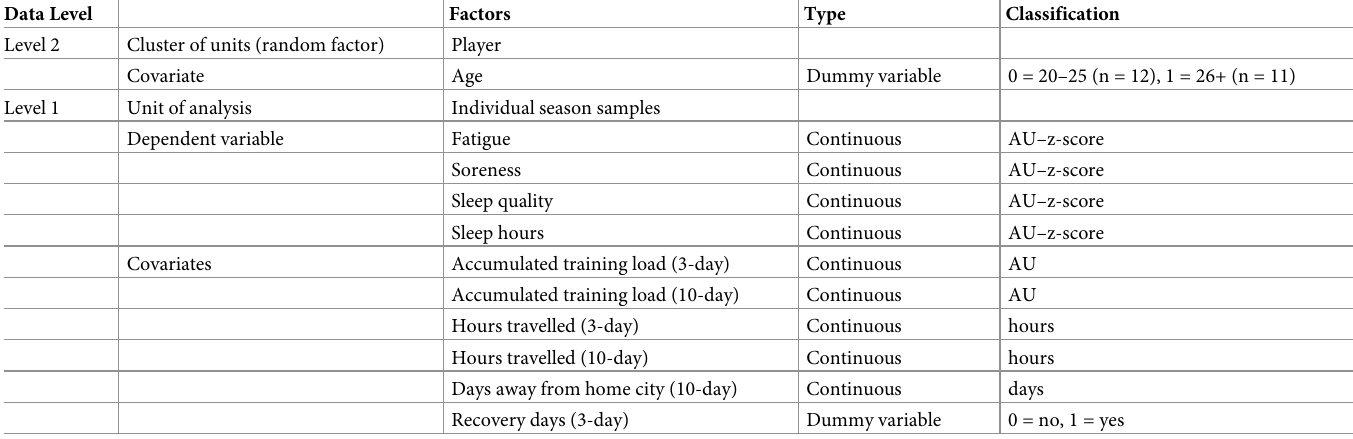
Table 1. Covariates included in model specification for athlete-reported outcome measures.